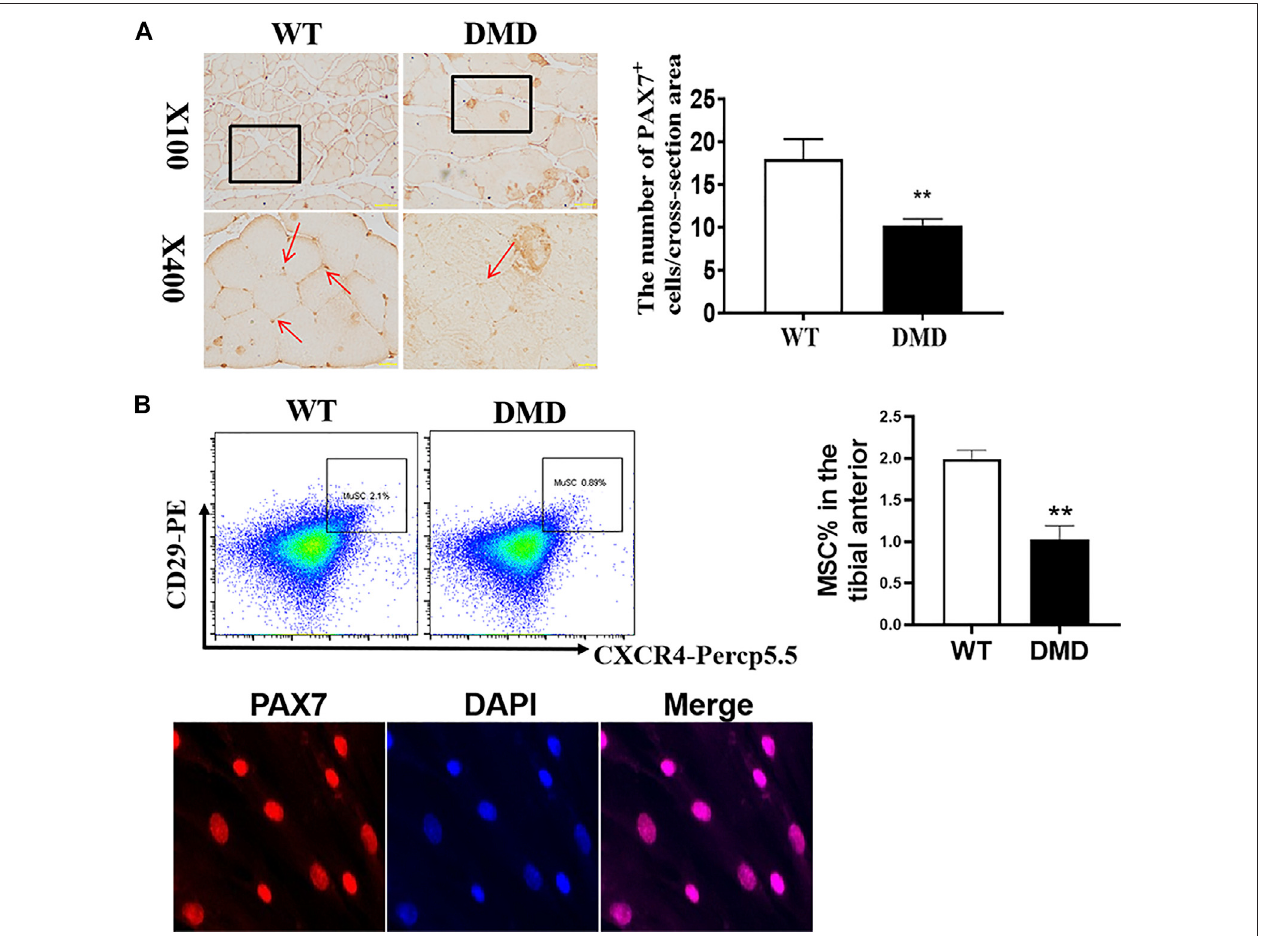
FIGURE3| ThenumbersofmusclestemcellsinDMDmicewerereducedinthetibialanterior. (A) Speci fi cstainingofmusclestemcells,PAX7antibody.ThePAX7 positivestainingisbrown(redarrow, leftpanel).PAX7positivecellswerecounted ineach fi eld. ThenumbersofPAX7positivecellsweredemonstratedasmeans±SEM ( n =6,rightpanel).** p < 0.01. (B) CD11b − CD45 − CD29 + CXCR4 + cellswerelabeled( fl owchart)andsortedoutforPAX7immunostaining.TheratioofWTtoDMDmuscle stem cells was compared. Data were presented at means ± SEM ( n = 6) with independent sample t -test. ** p < 0.01.